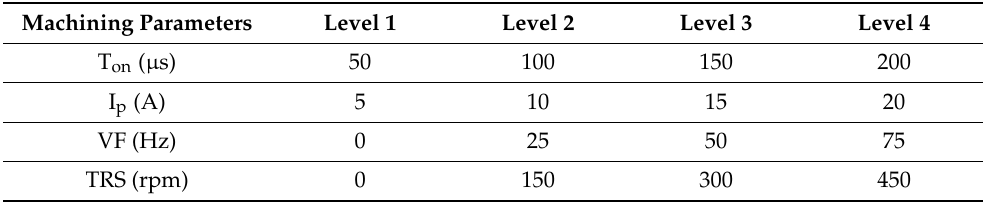
Table 4. Process parameters and their